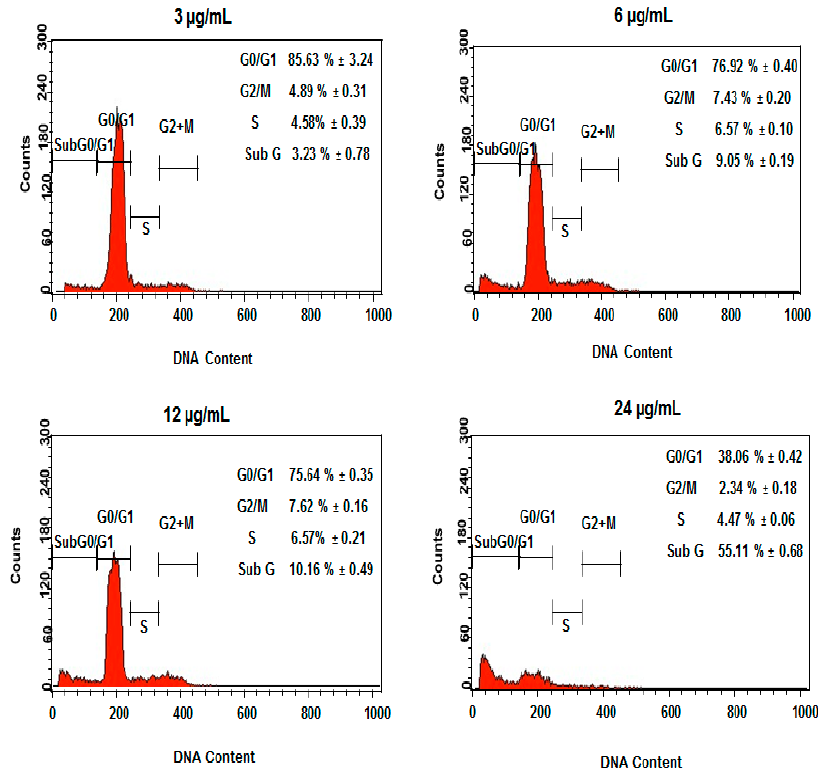
Figure 9. The concentrations ( 3, 6, 12 and 24 µg/ml) of DEN-HP β CD complex in HT29-treated cells included G2/M cell cycle arrest. Results are represented one of the three independent experiments.